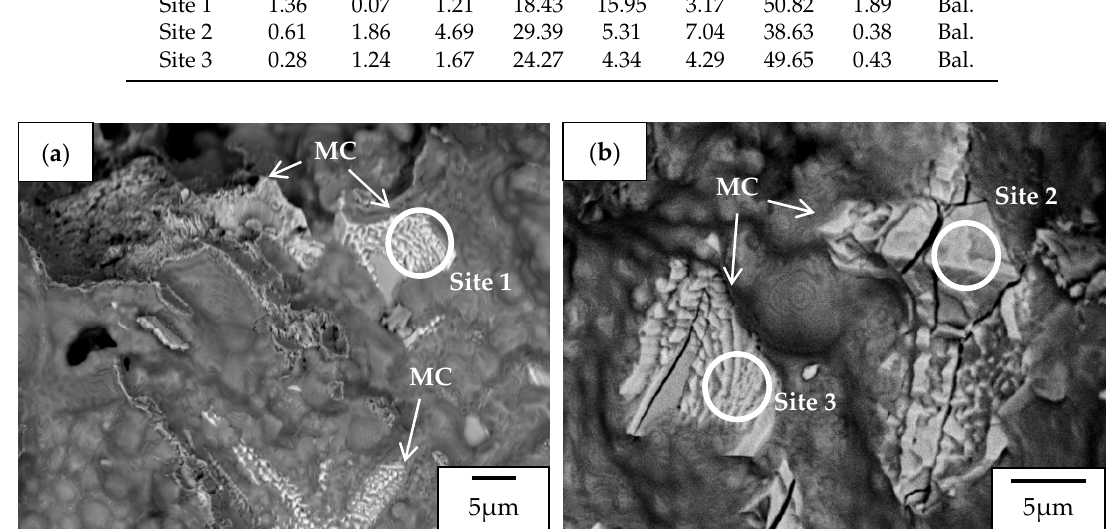
Table 3. EPMA chemical compositions in at % of the solidification products indicated in Figure 8. Element